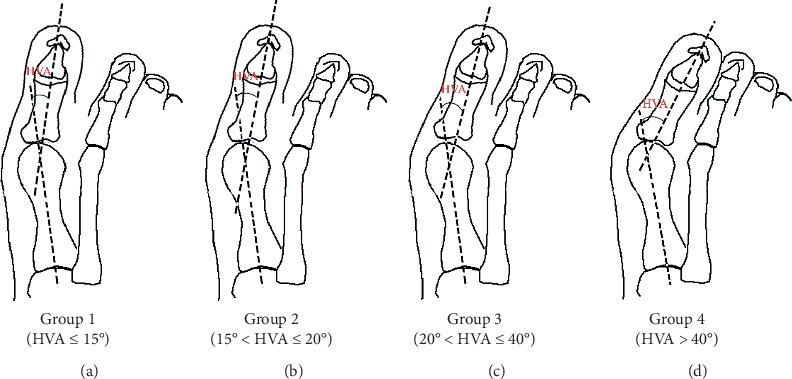
Diagram of four group patients: (a) mild HVA; (b) mild-moderate HVA; (c) moderate HVA; and (d) severity HVA.